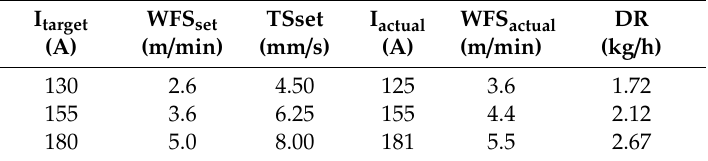
Table 4. Calibration of WFS and determination of DR for each selected current.